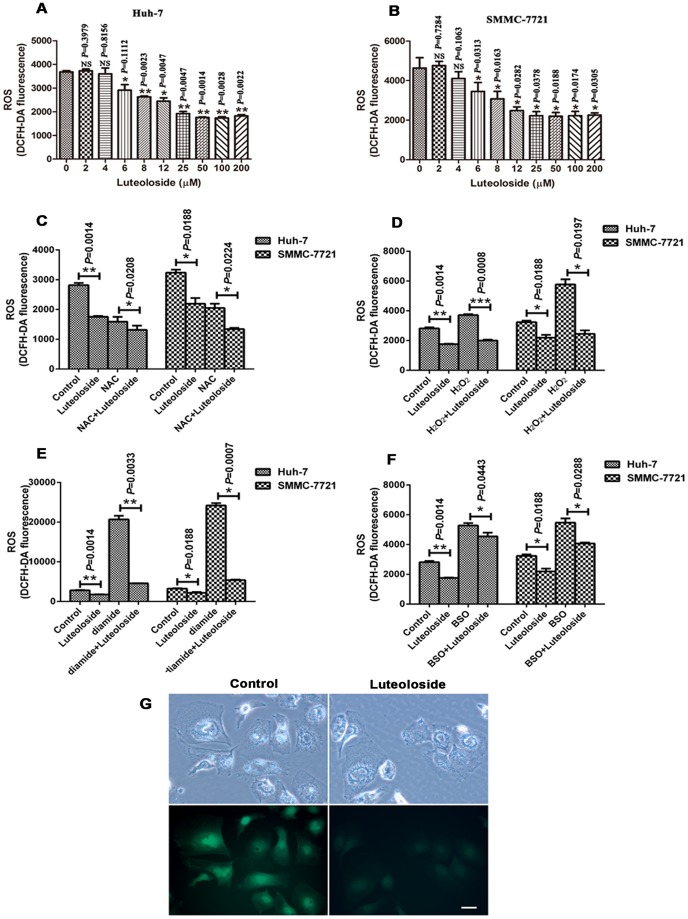
Luteoloside decreases intracellular ROS.ROS levels were measured using the ROS assay with DCFH-DA fluorescence dye. (A–B) Cells were treated with luteoloside at the indicated concentration for 8 h, then reacted with 10 µM DCFH-DA for 20 min. DCF fluorescence was determined on a Synergy H4 microplate reader. Cells were incubated with NAC (C), H2O2 (D), diamide (E) or BSO (F) for 4 h, followed by 50 µM luteoloside for 4 h. DCF was determined on a microplate reader. (G) DCFH-DA fluorescence (green) imaging of ROS in Huh-7 cells. Scale bar: 25 µm.